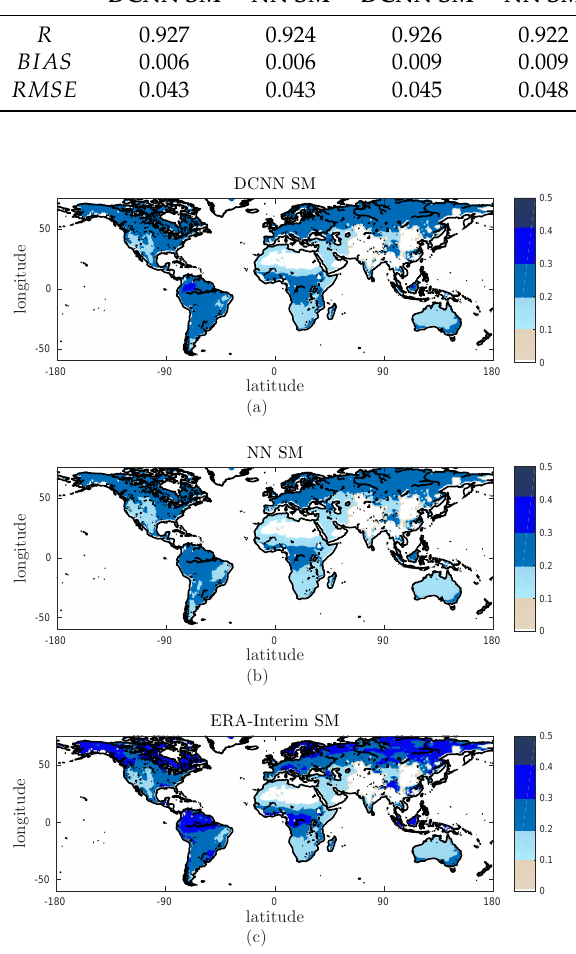
Figure 9. Spatial distribution of the yearly average SM values by DCNN and NN and the corresponding ERA-Interim SM for ascending overpass in testing phase from 1 January to 31 December 2016. ( a ) yearly average DCNN SM; ( b ) yearly average NN SM; ( c ) yearly average ERA-Interim